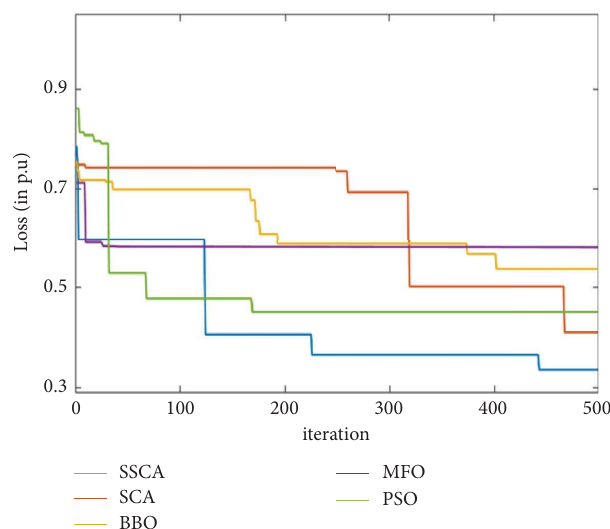
Figure 7: Loss variation in the IEEE-57 bus system at 115%